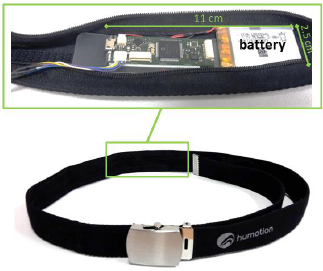
Figure 4. The sensor belt includes a 3D accelerometer, gyroscope and magnetometer, as well as a